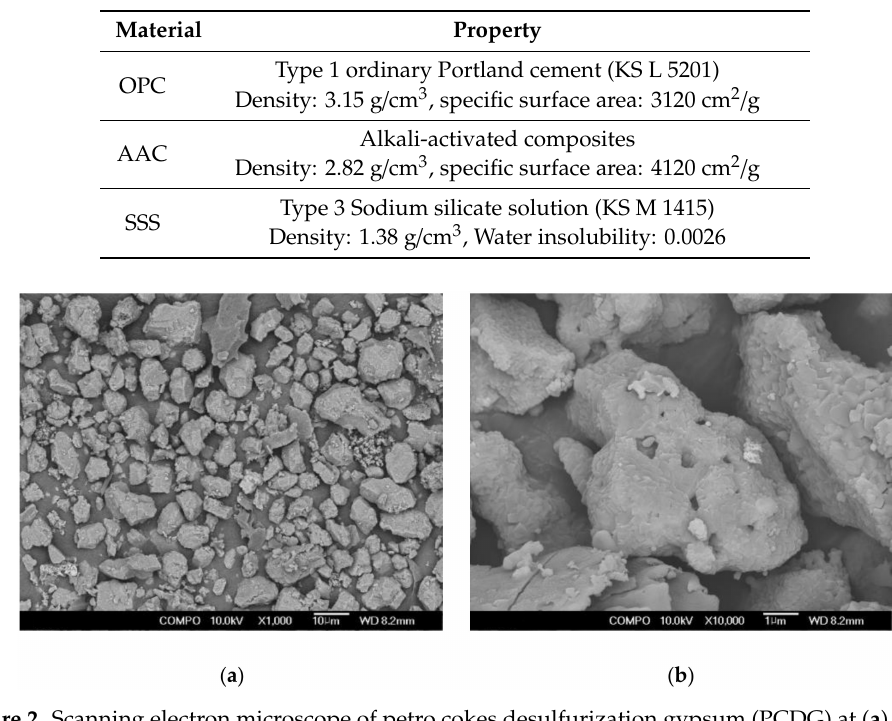
Figure 2. Scanning electron microscope of petro cokes desulfurization gypsum (PCDG) at ( a ) 1000 × and ( b ) 10,000 × magnification.